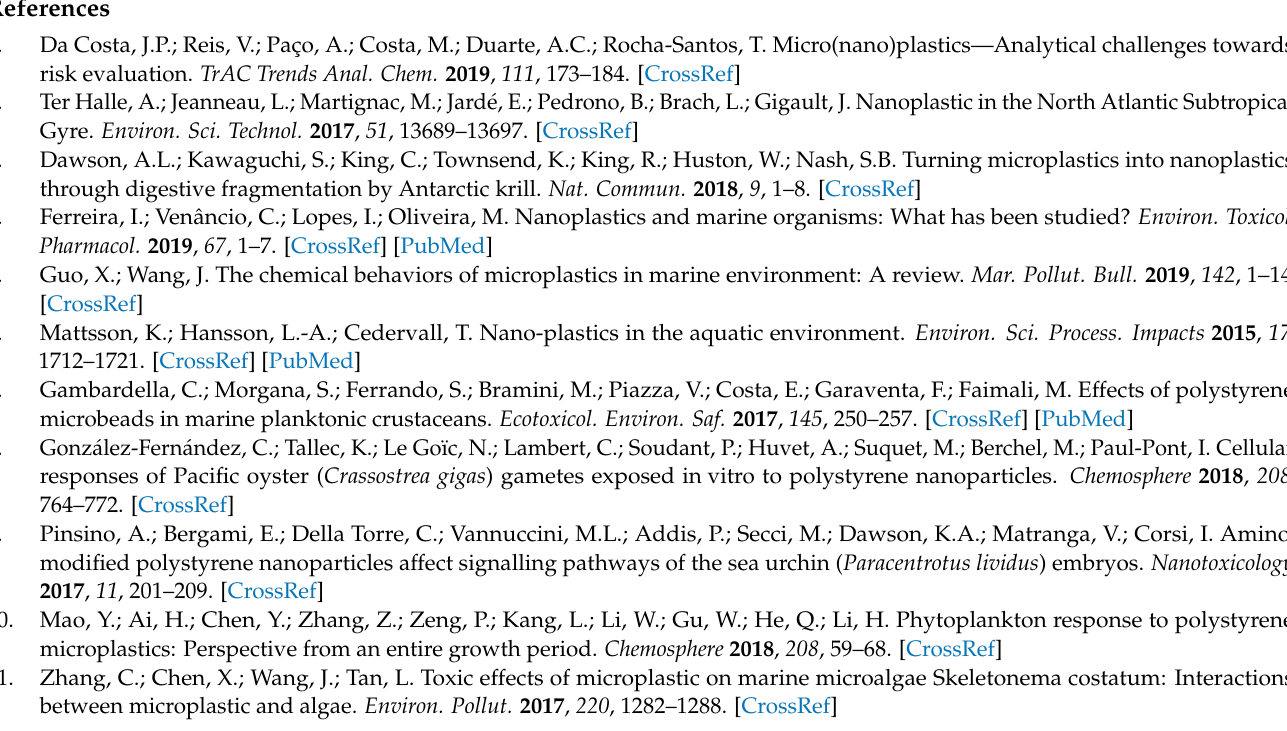
Figure S3: The hemolysis standard curve of digitalis saponin. The value of EC 50 is 1.53 µ g/mL, which means 1.53 µ g/mL digitalis saponins is equal to 1 HU, Table S1: Growth inhibition rate ( IR )